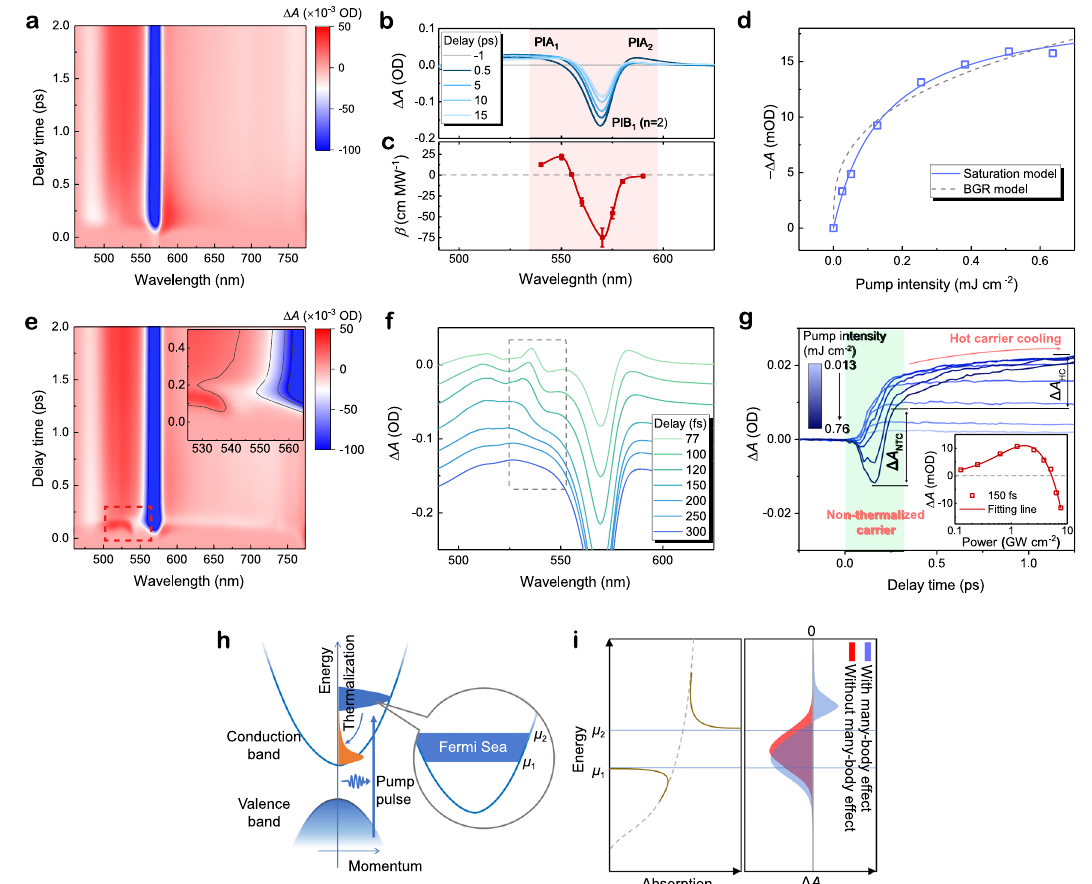
Fig. 3 | Ultrafast TA measurement ofquasi-2D perovskite fi lm. a Representative evolution within the fi rst 300fs and g pump fl uence dependent kinetics curves probedat540nmextractedfrom e .Greenregionhighlightsthenon-thermalization pseudocolour TA spectrum and b Time-dependent photo-induced changes in carrier kinetics within the fi rst 300fs. Red arrow in g outlines the subsequent hot- absorption ( Δ A ) which is pumped by 400nm femtosecond laser with excitation fl uence around 0.64mJ cm − 2 . c NLA coef fi cients extracted from Z-scan measure- carrier cooling process after thermalization. The non-thermalized carriers and hot carriersinducedabsorbancedifferenceislabeledby Δ A NTC and Δ A HC . Inset: power ments. Error bars represent the fi tting uncertainties with standard NLA model. d Experimental Δ A data(bluehollowdots)ofPIA 1 peak(530nm)at200fsdelayasa dependent Δ A (hollow dots) at 150fs delay fi tted with Eq. 2 (red solid line). h The function of pump intensity fi tted by the band-gap renormalization (BGR) model schematic shows the initial intra-band carrier relaxation process. i Sketched (gray dash line) of Δ A = A×I 1/3 and standard saturation model (blue solid line) of absorption spectrum based on nonequilibrium Fermi-sea. The left panel denotes 4 A = B (cid:3) I = ð 1+ I = I Þ , where B are constant, I the absorption singularities appear near the upper and lower boundary. The right S is saturable intensity with a value of S 0.16mJ cm − 2 (1.62GWcm − 2 ). e Pseudocolour representation of TA spectrum panel demonstrates Δ A spectra with/without many-body interaction in the pre- pumped by 540nm femtosecond laserwith an excitationintensity of 0.76mJcm − 2 . sence of a gaussian type non-thermalized carrier Inset: enlarged TA spectrum of the part labeled by the red frame. f Δ A spectra